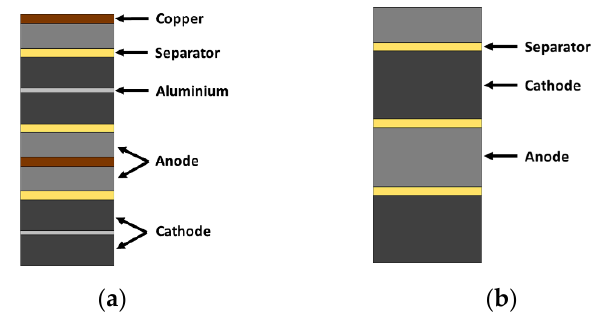
Figure 4. Types of heterogeneous modelling: ( a ) all layers resolved including current collectors; ( b ) unresolved anode and cathode.